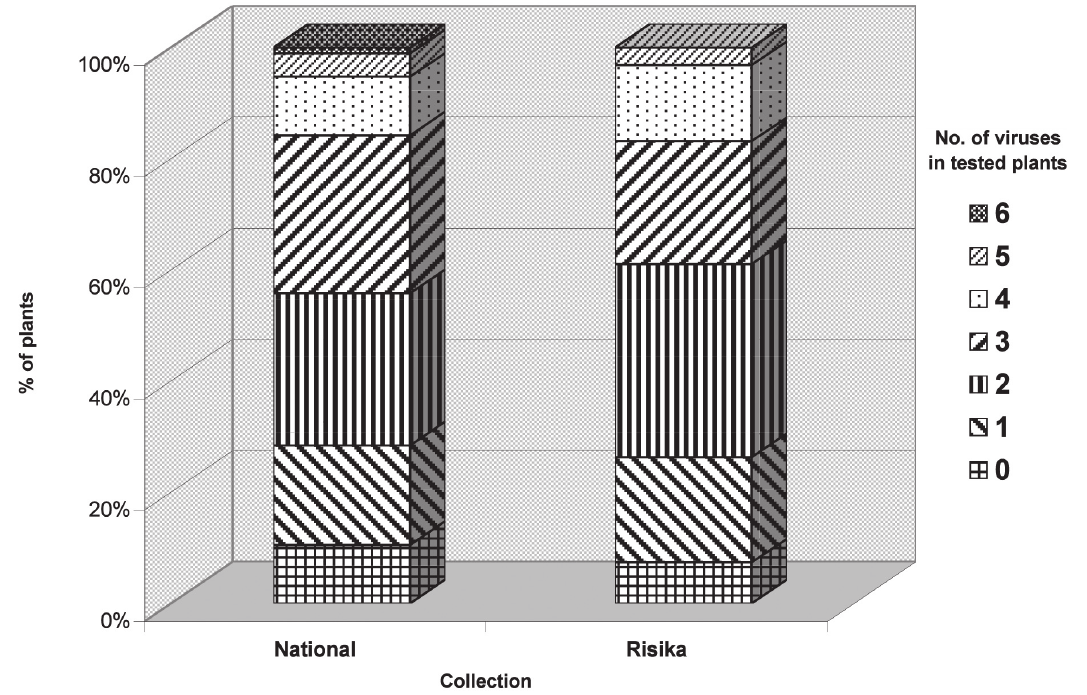
Figure 2. Percent ratio of plants from the National collection and from the Risika regional collection free of all eight tested viruses and those with single or multiple infections, as shown from ELISA